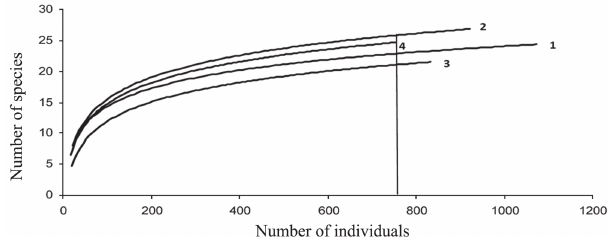
Fig. 2. Individual-based rarefaction curves by zone (1, 2, 3, 4) for species richness in the Paraíba do Sul River and Funil Reservoir.